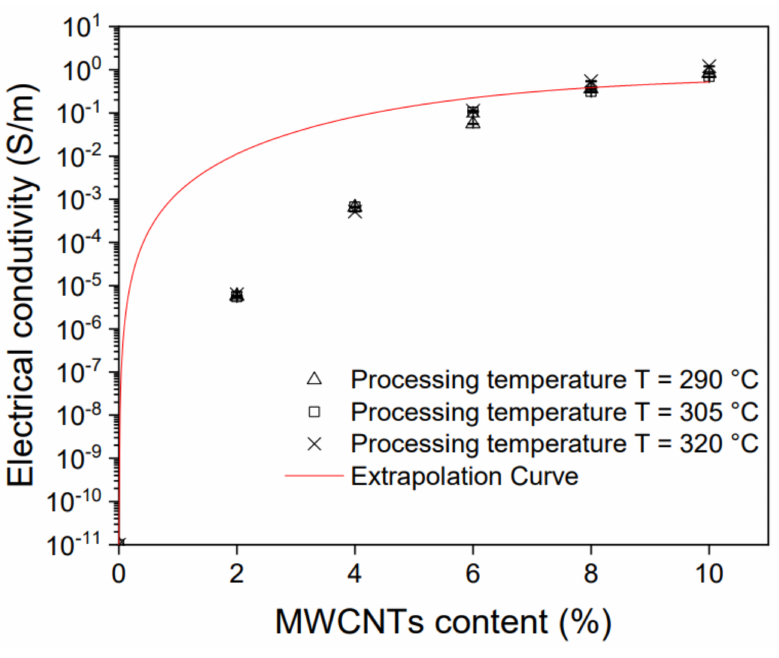
Figure 6. Electrical conductivity of PPS/MWCNT